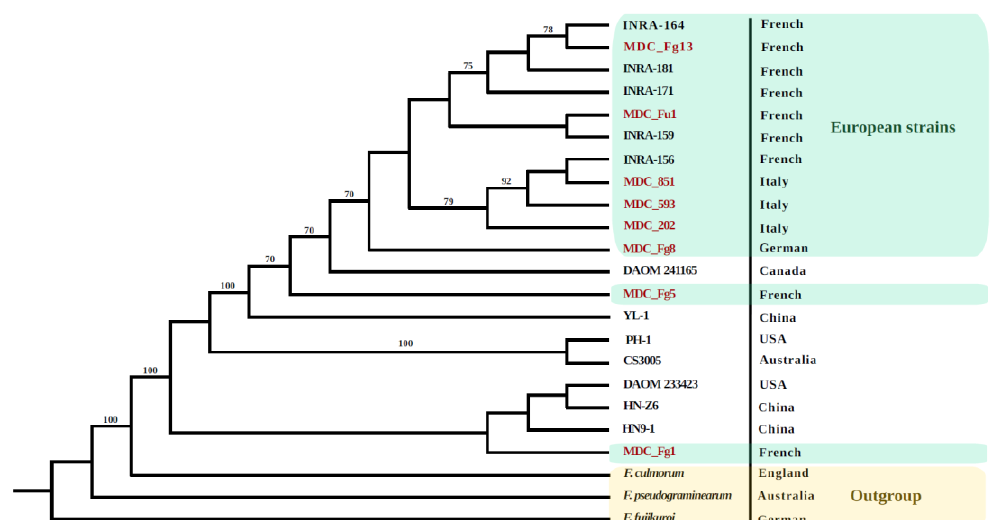
Figure 2. Phylogenetic relationship of 20 F. graminearum strains from different geographic origins. A Maximum likelihood bootstrapped cladogram was generated from 7640 single-copy protein sequences found in the 20 F. graminearum strains and from 3 other species of the Fusarium genus used as an outgroup ( F. pseudograminearum , F. culmorum and F. Fujikuroi ). Numbers at nodes indicate a bootstrap value greater than 70%, performed with 1000 replications. The country of origin is shown on the right. Names of the 8 strains characterized in this study are shown in